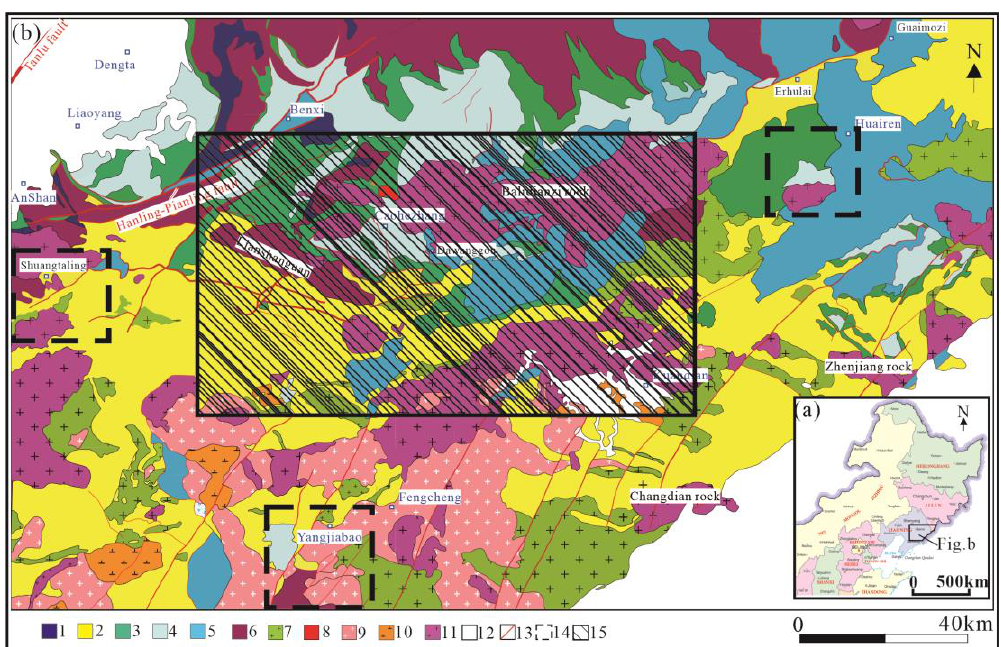
Figure 7. Simplified geological map of the study area (after the 1:500,000 geological map produced by the Geological Survey of China, modified from [43]). 1. Archean. 2. Paleoproterozoic. 3. Mesoproterozoic- Neoproterozoic. 4. Paleozoic. 5. Mesozoic. 6. Archean granitic gneiss. 7. Paleoproterozoic granite. 8. Early Triassic basic-ultrabasic complex. 9. Triassic granite. 10. Late Triassic granite. 11. Yanshanian granite. 12. Other geological units. 13. Fault. 14. Location of test area. 15. Location of